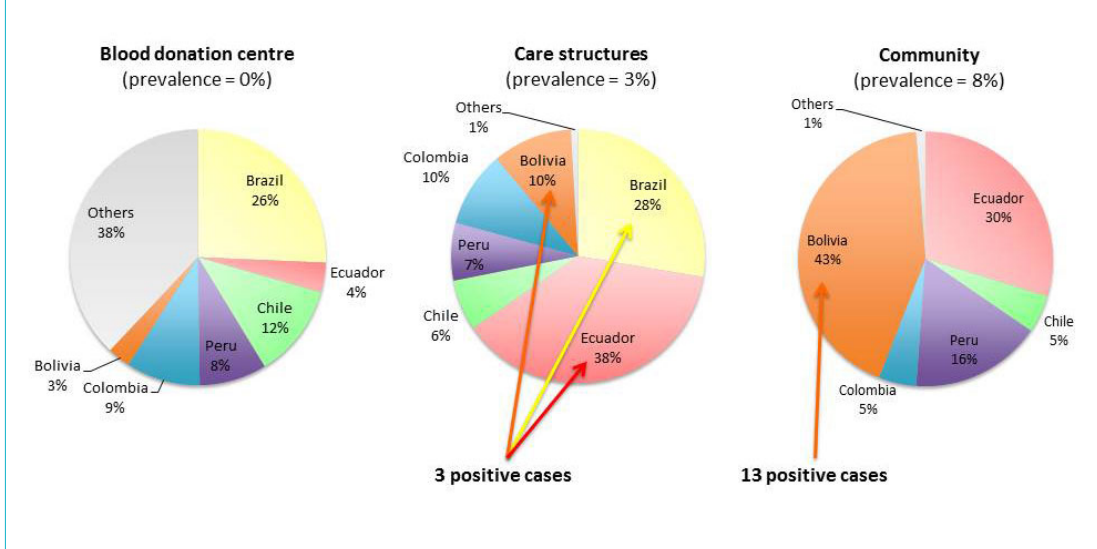
Figure 2: Number of persons tested for Chagas disease by country and by screening place. Groups with positive cases are pointed with arrows. Care structures include the Department of Ambulatory Care and Community Medicine (DACCM), the Point d’Eau (PDE), the family planning centres (FPC) and the maternity hospital.